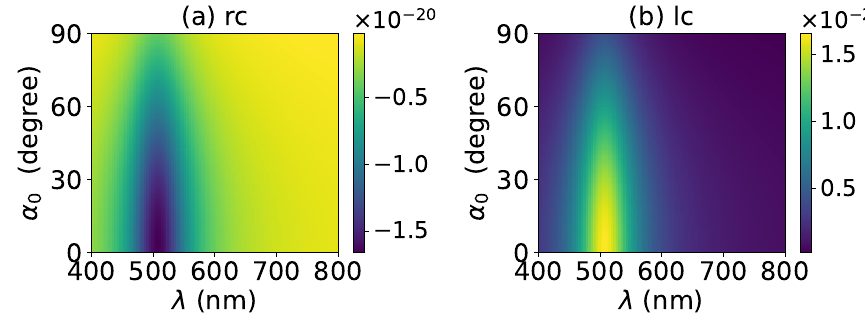
Figure 23. The same as in Figure 20, but with N = 3.